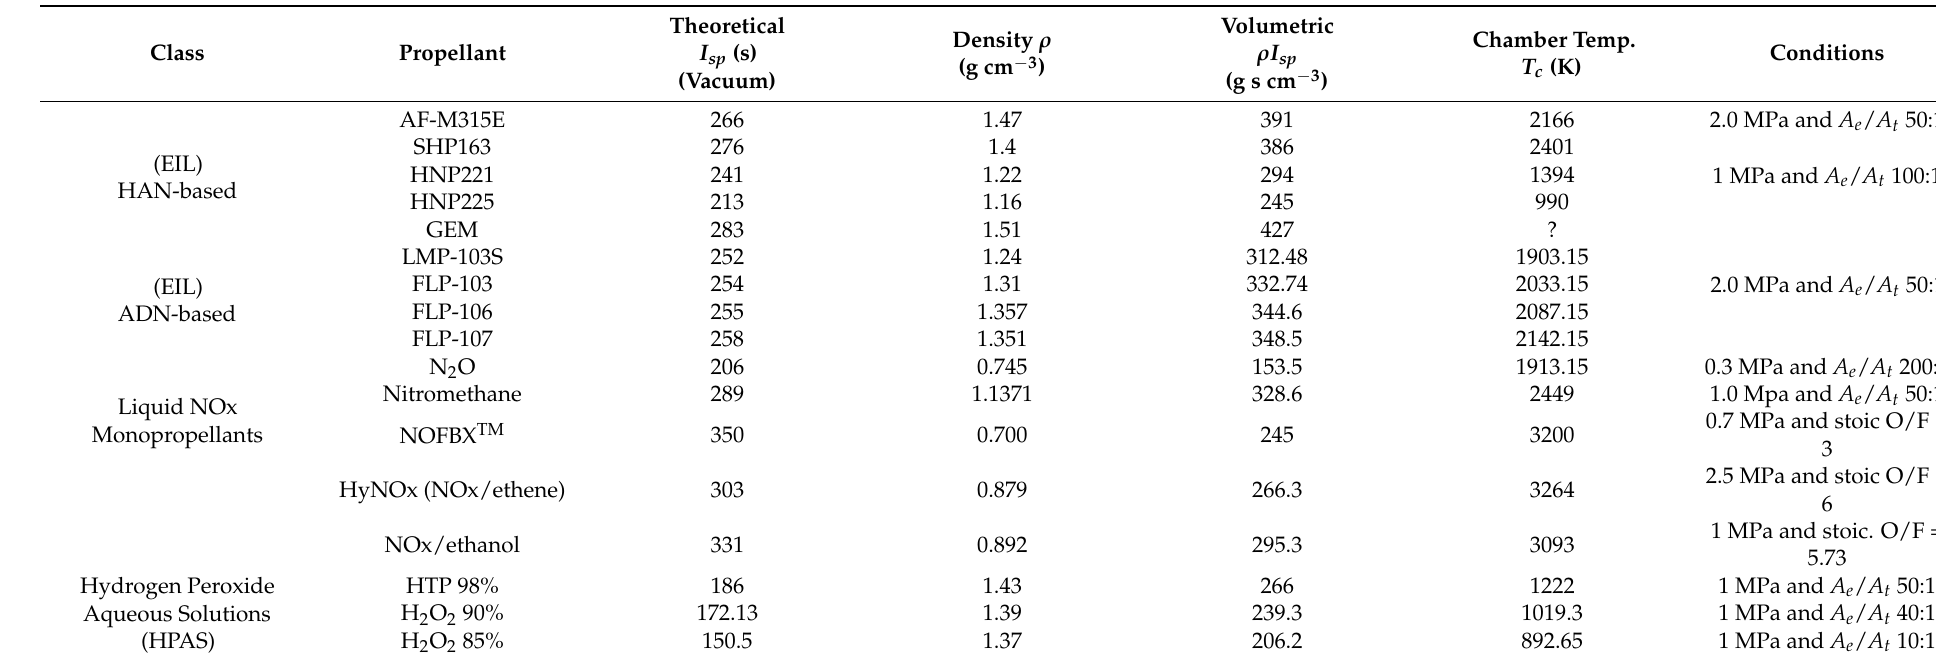
Table 8. Performance and physical parameters of state-of-the-art green monopropellants. (Ideal vacuum specific impulse; Density at 20 ◦ C and 1 atm storage conditions).